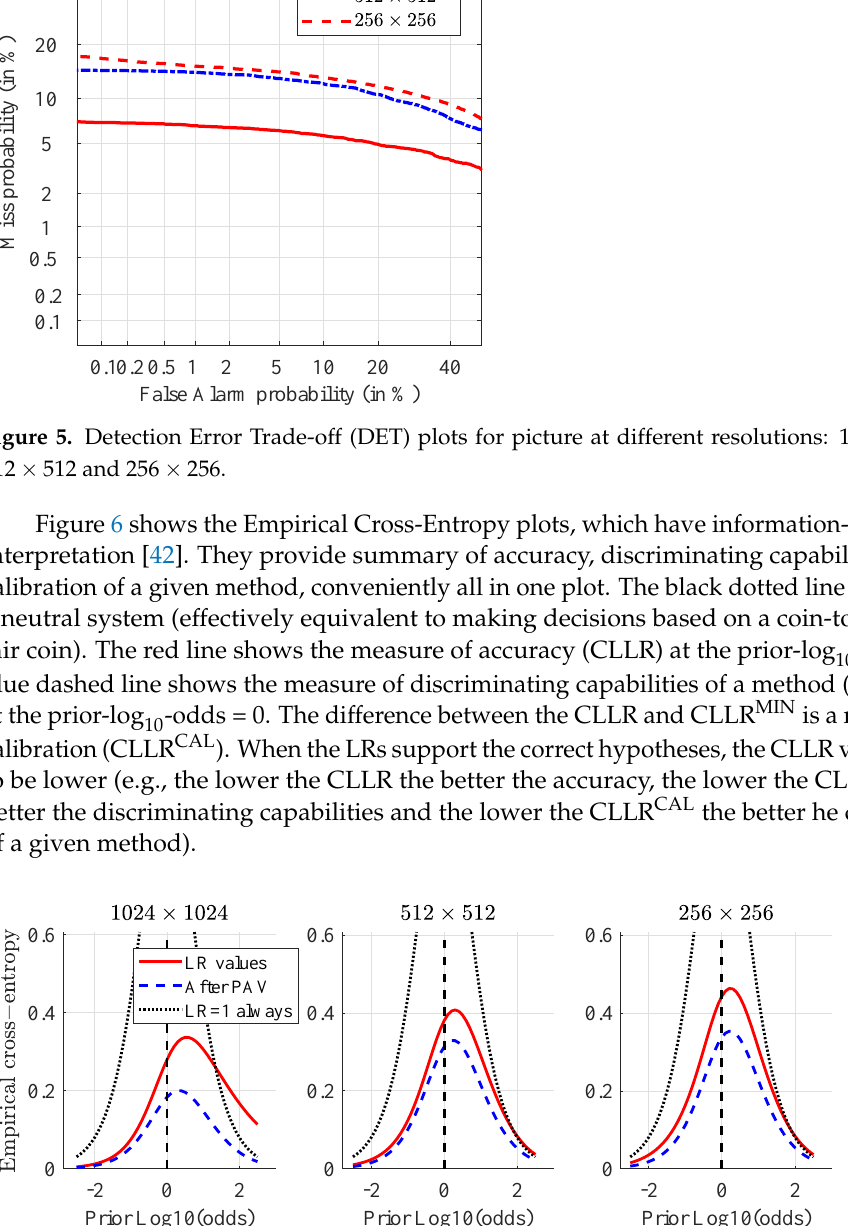
Figure 6. Empirical Cross Entropy (ECE) plots for pictures at different resolutions: 1024 × 1024, 512 × 512 and 256 ×